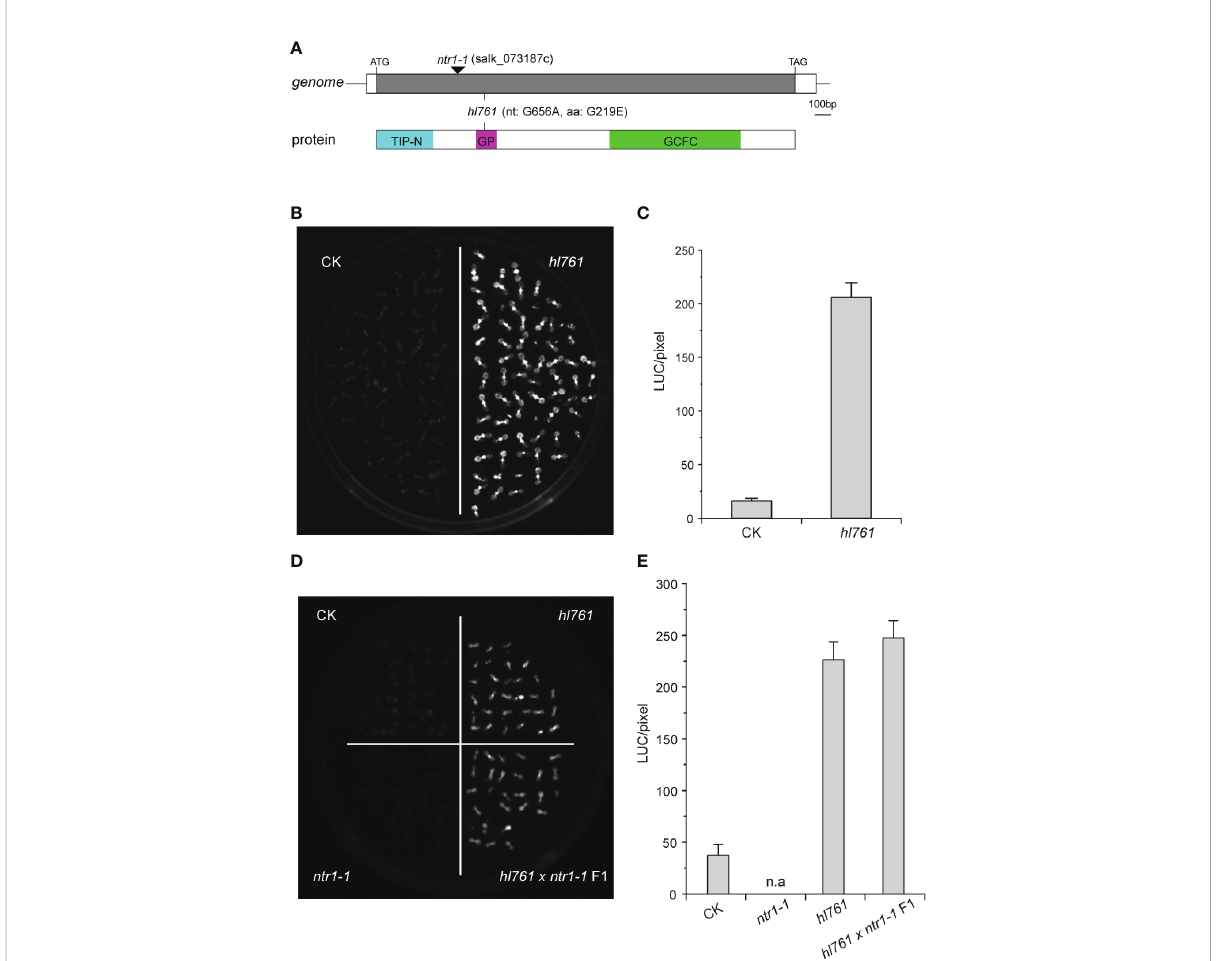
FIGURE 1 Mutant hl761 harbors a point mutation of NTR1 . (A) Schematics of the position of hl761 mutations in the genome and protein. The black triangle shows the insertion place for T-DNA mutant ntr1-1 . The color boxes in the lower panel indicate the conserved domains of NTR1. TIP-N, Tuftelin interacting protein N terminal domain; GP, G-patch domain; GCFC, GC-rich sequence DNA-binding factor-like protein domain. (B) LUC activity in 38°C 1-h heat-treated hl761 mutant and control plant (CK) seedlings. (C) Quanti fi cation of LUC activities in seedlings shown in (B) Error bar stands for SE, n = 20. (D) LUC activity for the cross-complementation test. Samples were 38°C heat treated for 1 h. (E) Quanti fi cation of LUC activities in seedlings shown in (D) Error bar stands for SE, n = 10. n.a, not applicable; CK, background line for hl761.